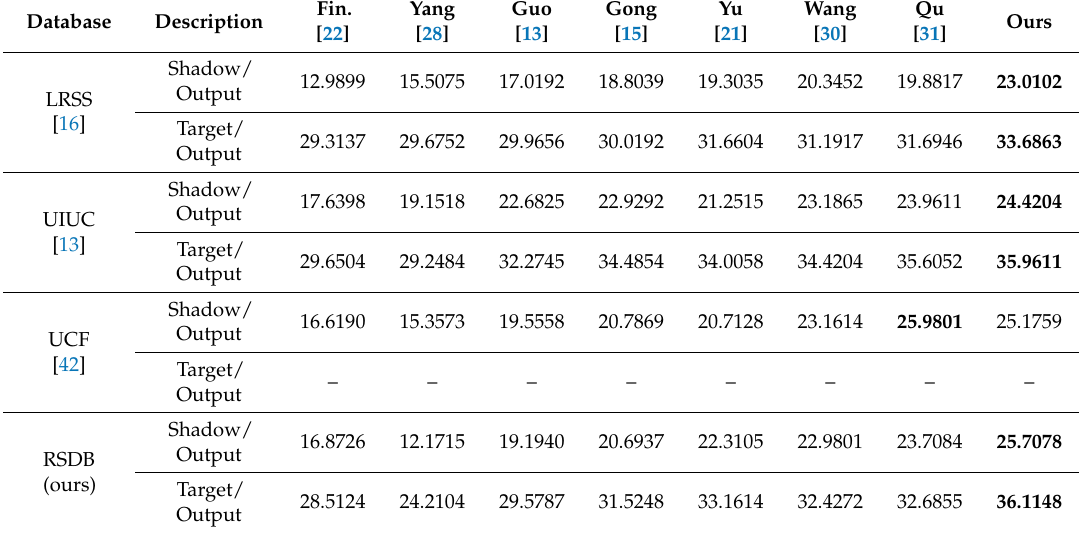
Table 3. Quantitative results using peak signal-to-noise ratio (PSNR) (the bigger the better), the maximum value is shown in bold.